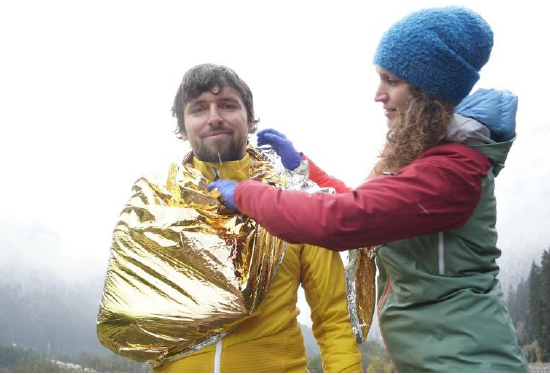
Figure 2. Application of a rescue blanket as arm-sling or triangular bandage.